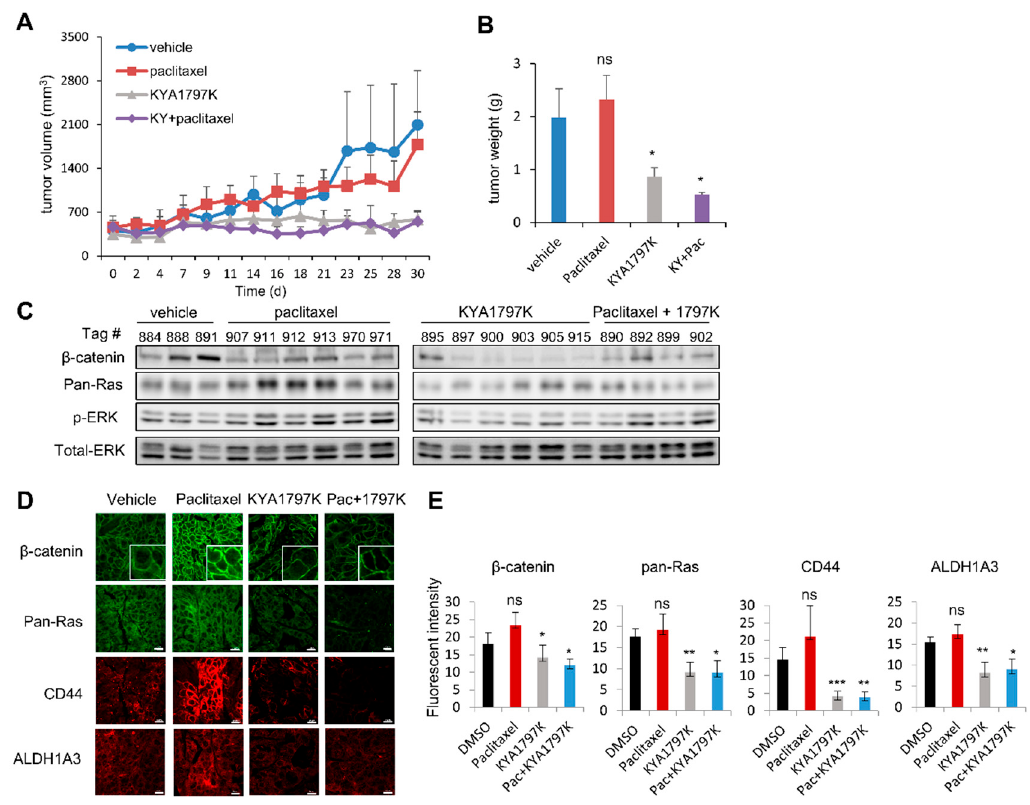
Figure 5. E ff ects of KYA1797K and paclitaxel on the growth of FOLFOX-resistant PDX tumors. Mice bearing FOLFOX-resistant tumors were treated with vehicle, or with paclitaxel (10 mg / kg), KYA1797K (25 mg / mL) or both, when the tumor reached a volume of 100–200 mm 3 . KYA1797K and paclitaxel were administered as described in the Method section. Subcutaneous tumor volumes were measured using calipers. ( A ) Tumor volumes of mice were measured for 30 days. ( B ) Tumor weight was measured at the time of sacrifice. ( C ) Immunoblot analyses using WCLs of PDX tumors ( n = 3 vehicle, n = 6 paclitaxel, n = 8 KYA1797K, and n = 5 paclitaxel + KYA197K) ( A ), except for tumors that were too small (two tumors in the KYA1797K group and one tumor in the co-treatment group), to perform the above experiment with the indicated antibodies. ( D , E ) Formalin-fixed 4- µ m para ffi n sections of the PDX tumors ( A ) were evaluated by IHC analyses by using β -catenin, pan-Ras, CD44, or ALDH1A3 antibody and by mean fluorescence intensities of the markers for at least three di ff erent tissue samples using NIS-Elements AR 3.1 (Nikon; Melville, New York, USA). Two-sided Student’s t -test was used to determine statistical significance. Error bars represent 95% confidence intervals. * P < 0.05, ** P < 0.005., *** P < 0.0005. Scale bar = 10 µ